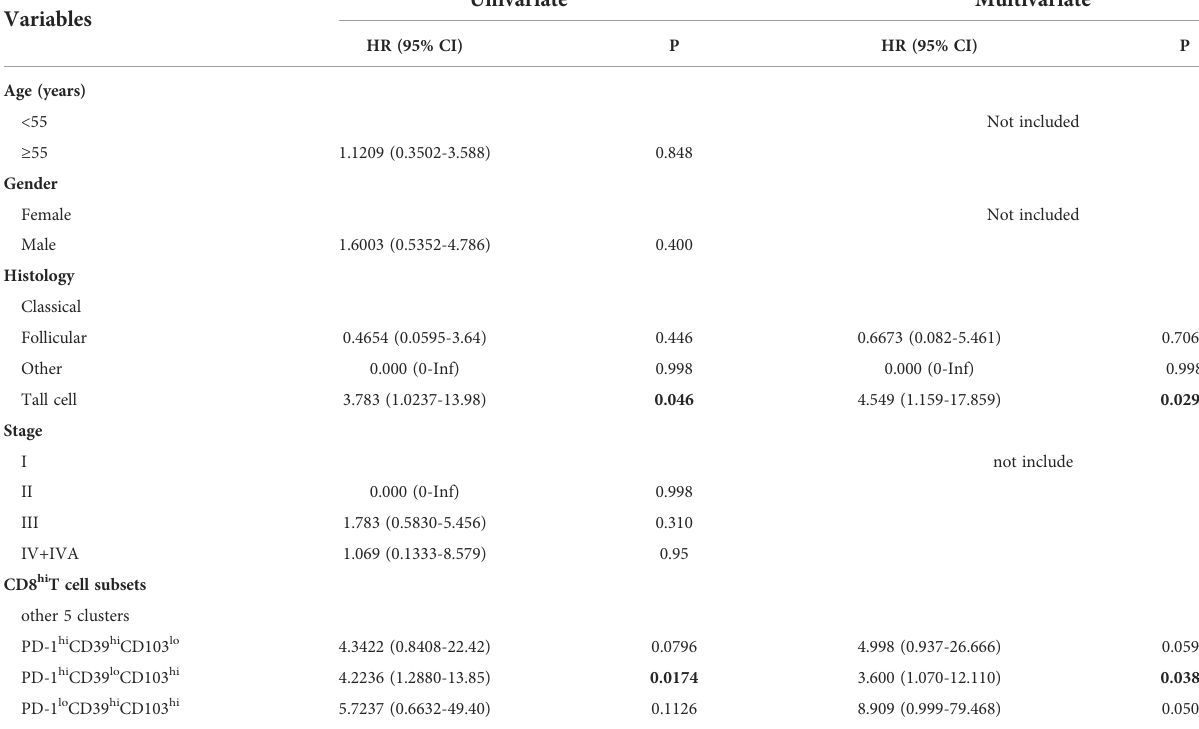
TABLE 3 Univariate and multivariate Cox proportional hazard models for recurrence-free